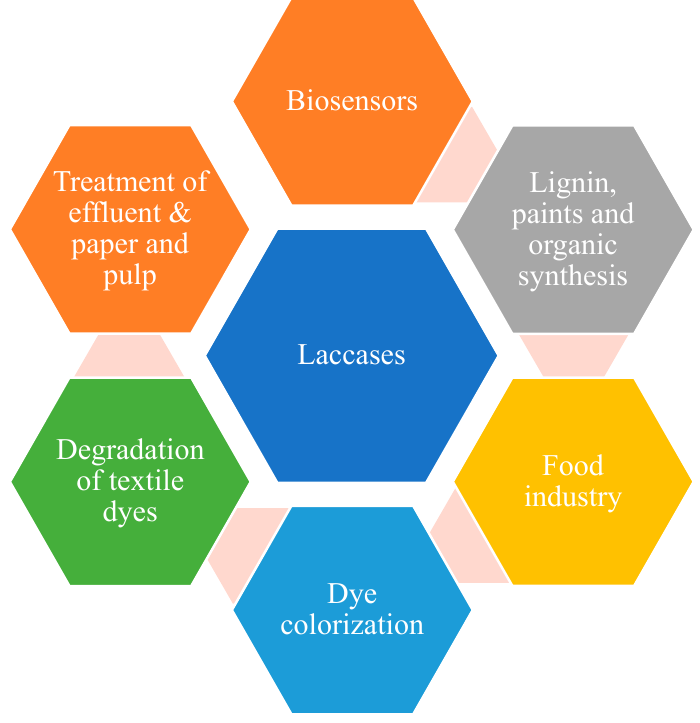
Figure 5. Applications of laccases.